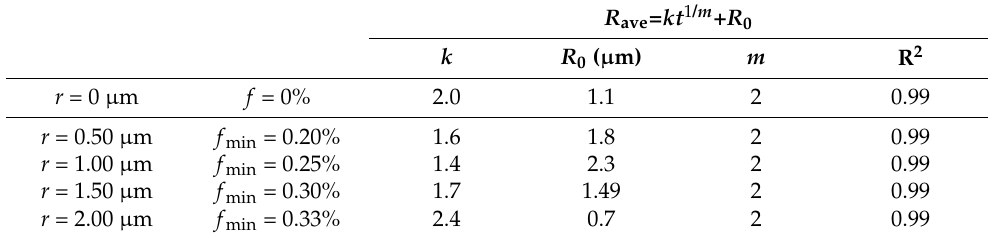
Table 2. Variation of the parameters in the grain-growth-index equation with SPP volume fraction.